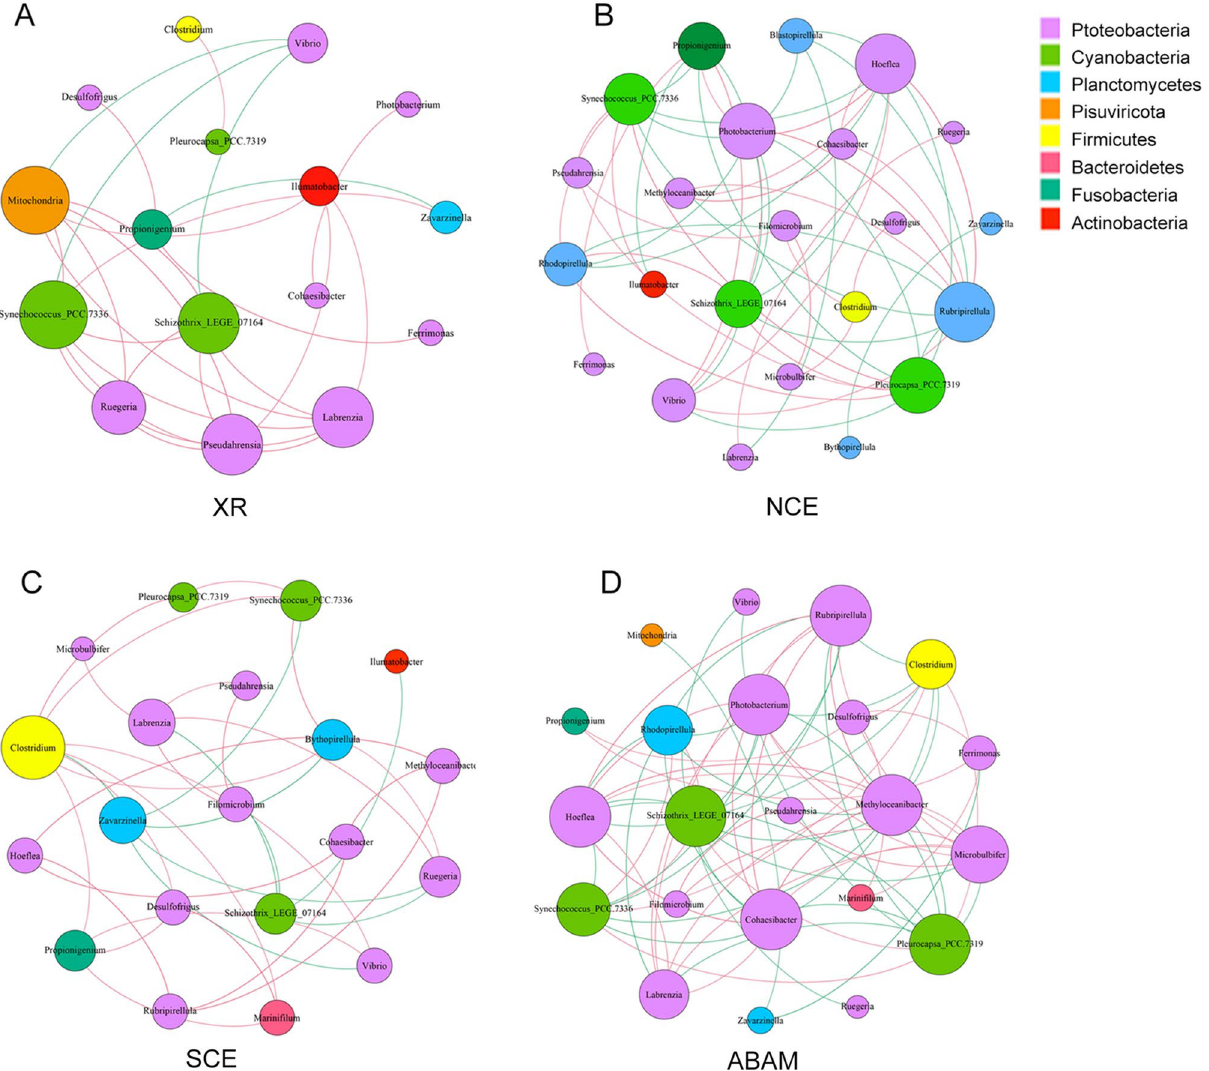
Figure 5. Co-occurrence network analysis at genus level on XR ( A ), NCE ( B ), SCE ( C ), and ABAM ( D ) group. The node colors represent different phyla as shown in the color key. The sizes of genus nodes are proportional to their relative abundance. The red and green edges represent positive and negative correlations,